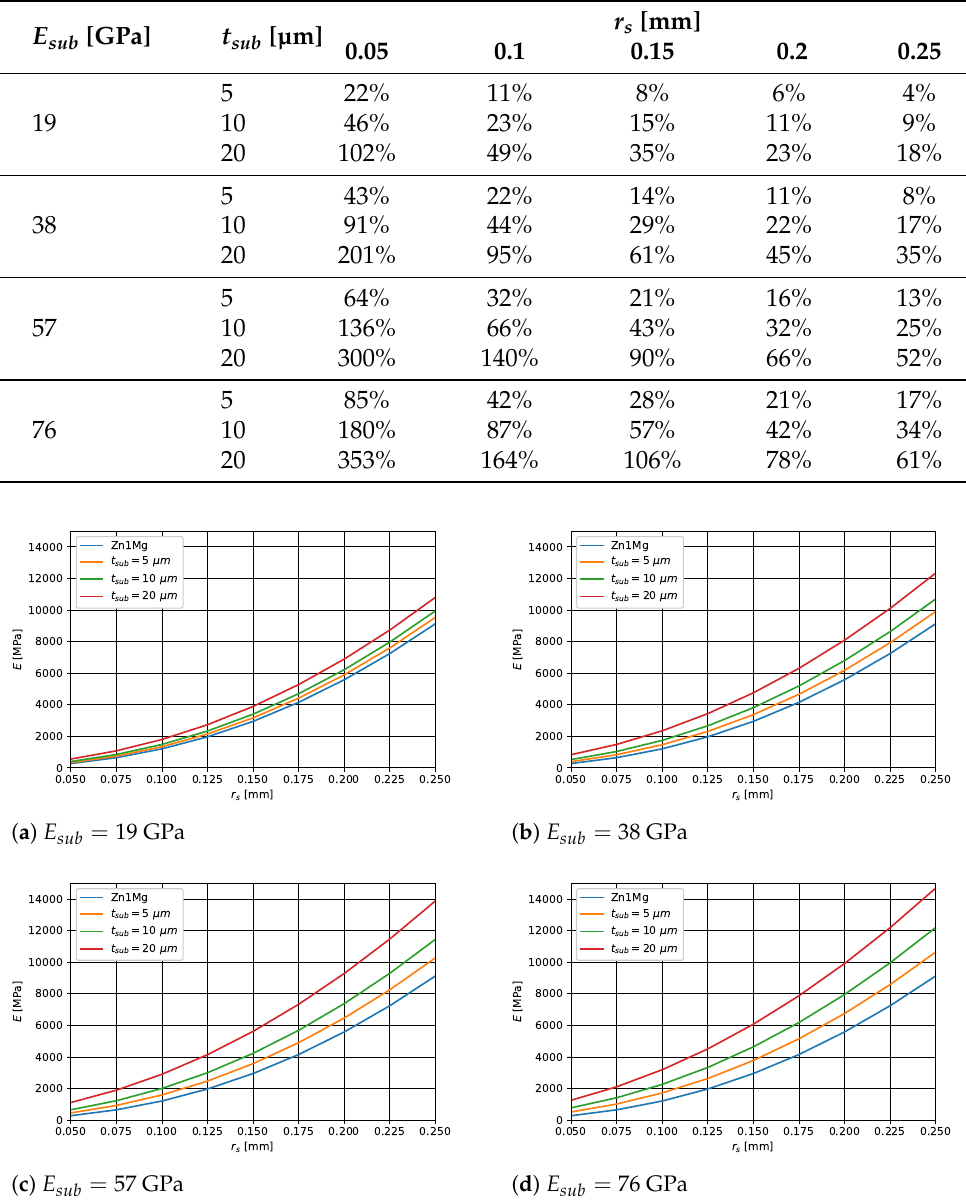
Figure 11. Results of the FE simulations of corroded scaffolds for varying